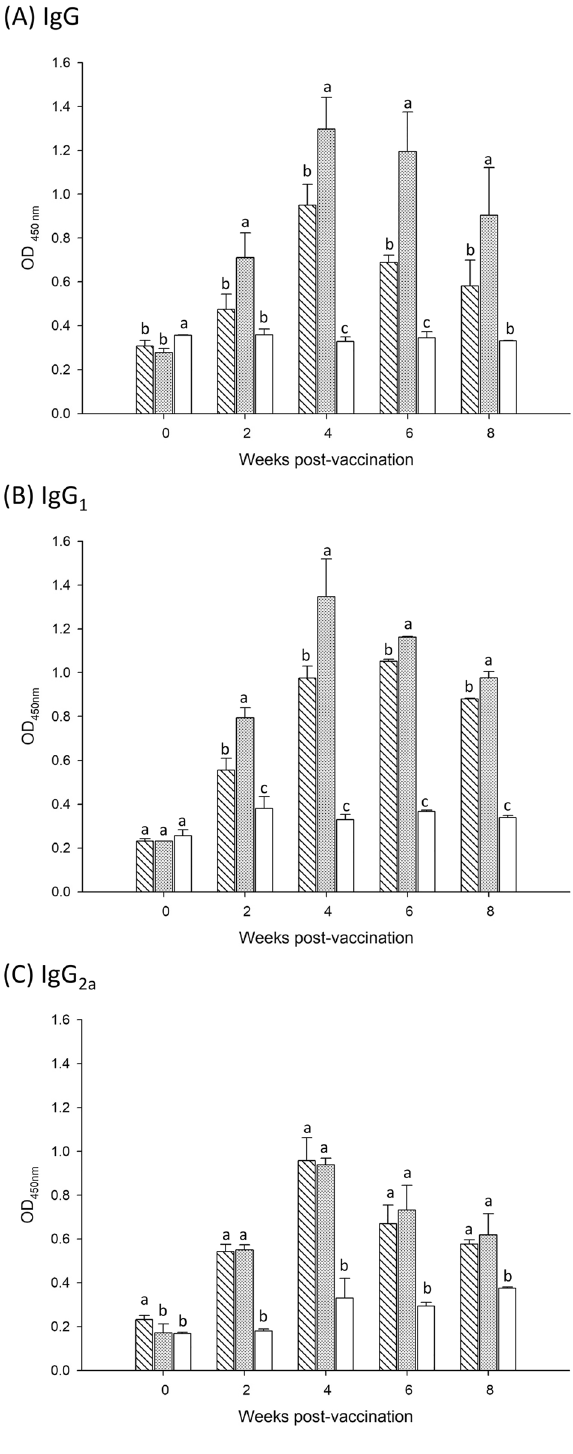
Figure 3. ELISA analysis of BVDV-specific antibody responses induced by truncated E2 glycoprotein: ( A ) total IgG, ( B ) IgG 1 , and ( C ) IgG 2a . Antibody responses in mice were assessed at 0, 2, 4, 6, and 8 weeks after intraperitoneally immunization with 5 or 35 μg of truncated E2 glycoprotein or PBS. Mice were injected twice at weeks 0 and 2. Data are presented as mean absorbance values ± standard deviations. Different letters (a, b, c) on the bar indicate significant ( P < 0.05) between-group differences at the same time point using Duncan’s test. ( ) Group I: 5 μg of truncated E2 glycoprotein; ( ) Group II: 35 μg of truncated E2 glycoprotein; ( ) Group III: